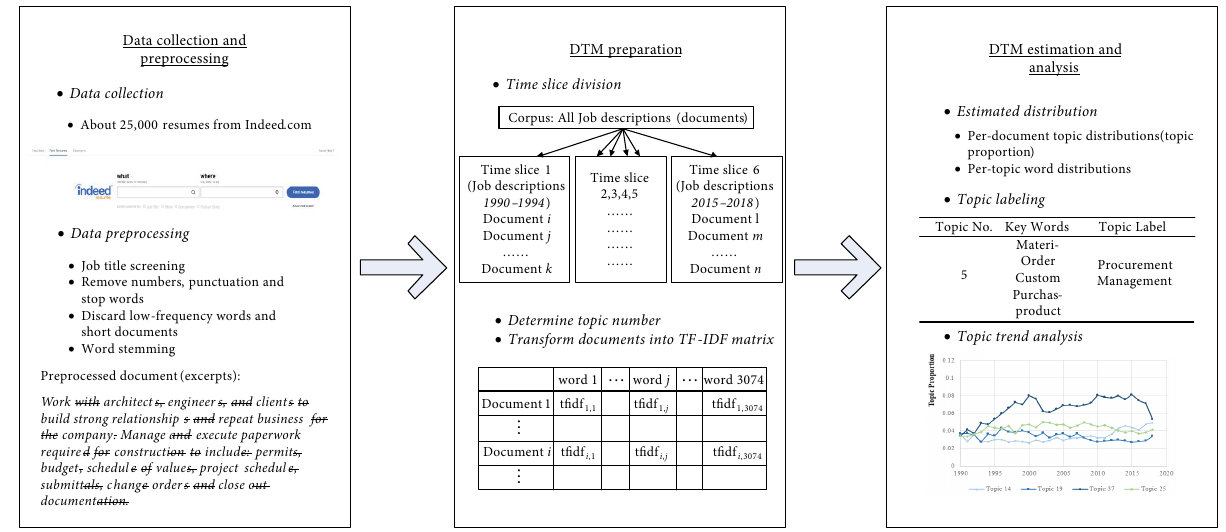
Figure 1. Data analysis procedure